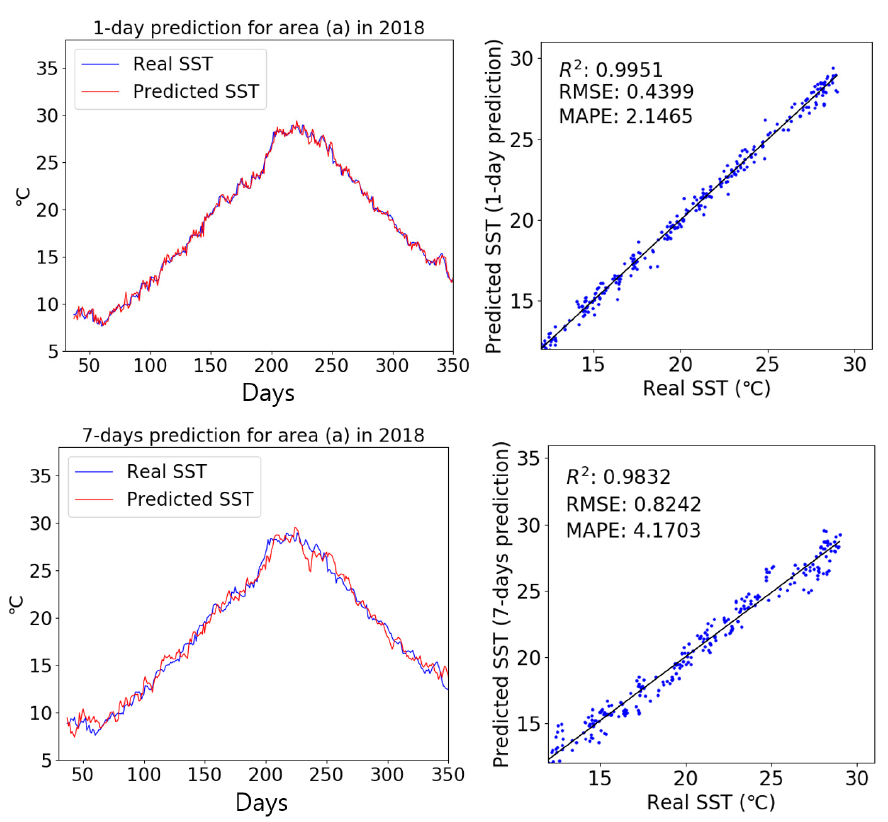
Figure 10. Comparison of predicted and real SST data, with scatter diagrams, for 1-day and 7-days prediction intervals using the multi dataset as input.